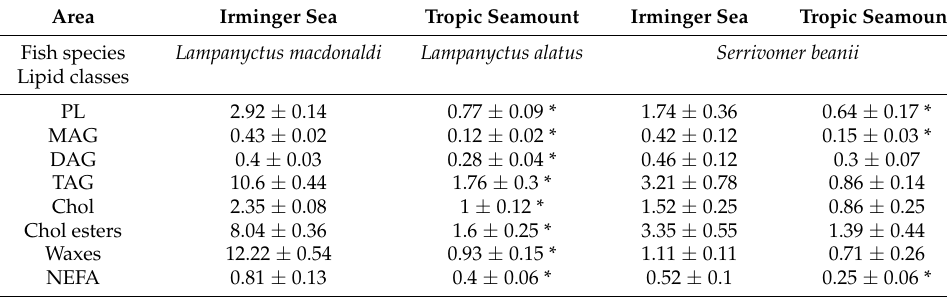
Table 1. The content of lipid classes (% dry weight) in muscle tissue of the studied mesopelagic fishes from Irminger Sea and Tropic Seamount.